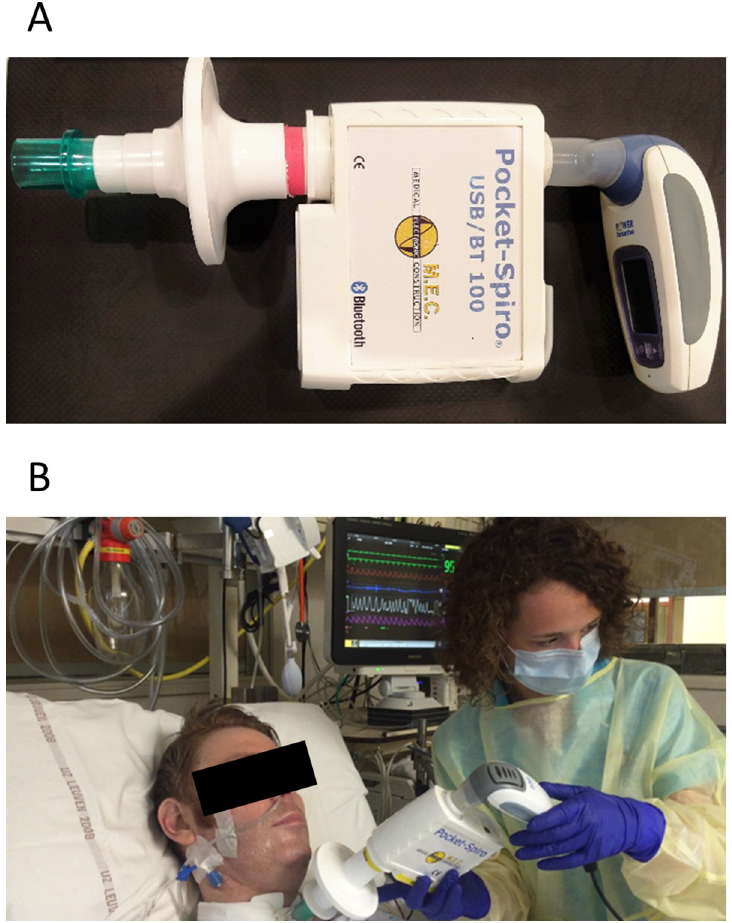
Fig 1. Setup of measurements. Inspiratory muscle training was performed with the portable spirometer placed between the electronic inspiratory training device (Panel A) and connected to the patient either via an endotracheal tube or via a tracheostomy (Panel